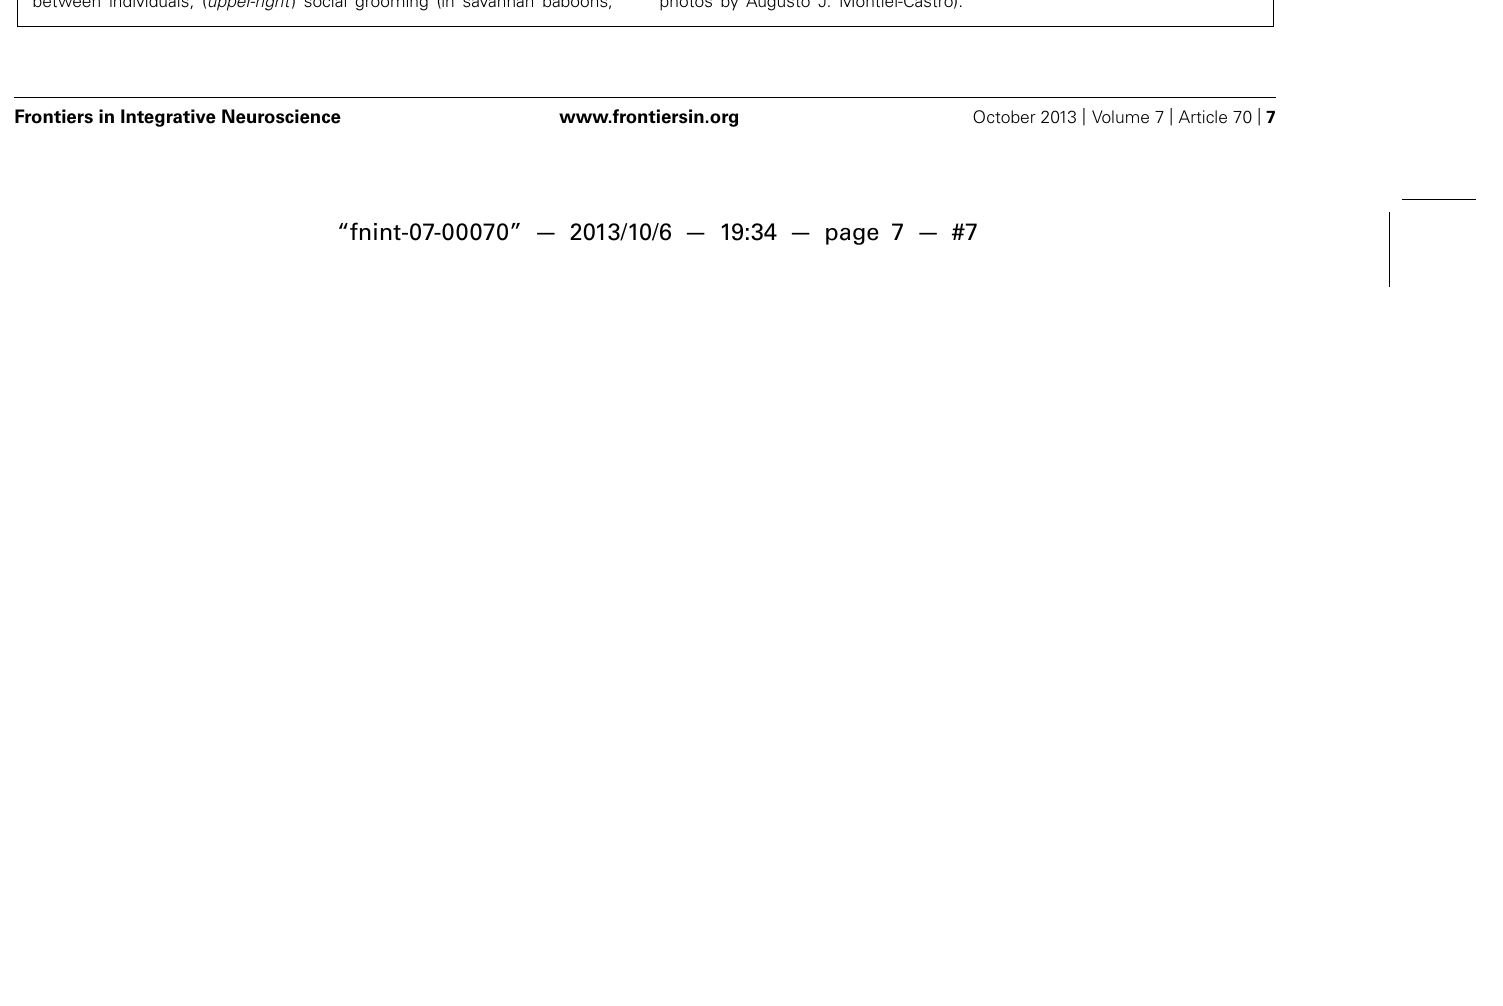
FIGURE 3 | Behaviors supporting an association between microbial- transmission and social bonding in primates. The intense sociality of primates provides several different direct (i.e., with contact between individuals) and indirect (i.e., mediated by any environmental feature) opportunities for the transmission of microbial-life associated to a social-bonding mechanism. Important examples (described in more detail in main text) include: ( upper-left ) mouth-to-mouth contact (in chimpanzees, Pan troglodytes ): where microbial-life may be directly transmitted in saliva between individuals; ( upper-right ) social grooming (in savannah baboons,